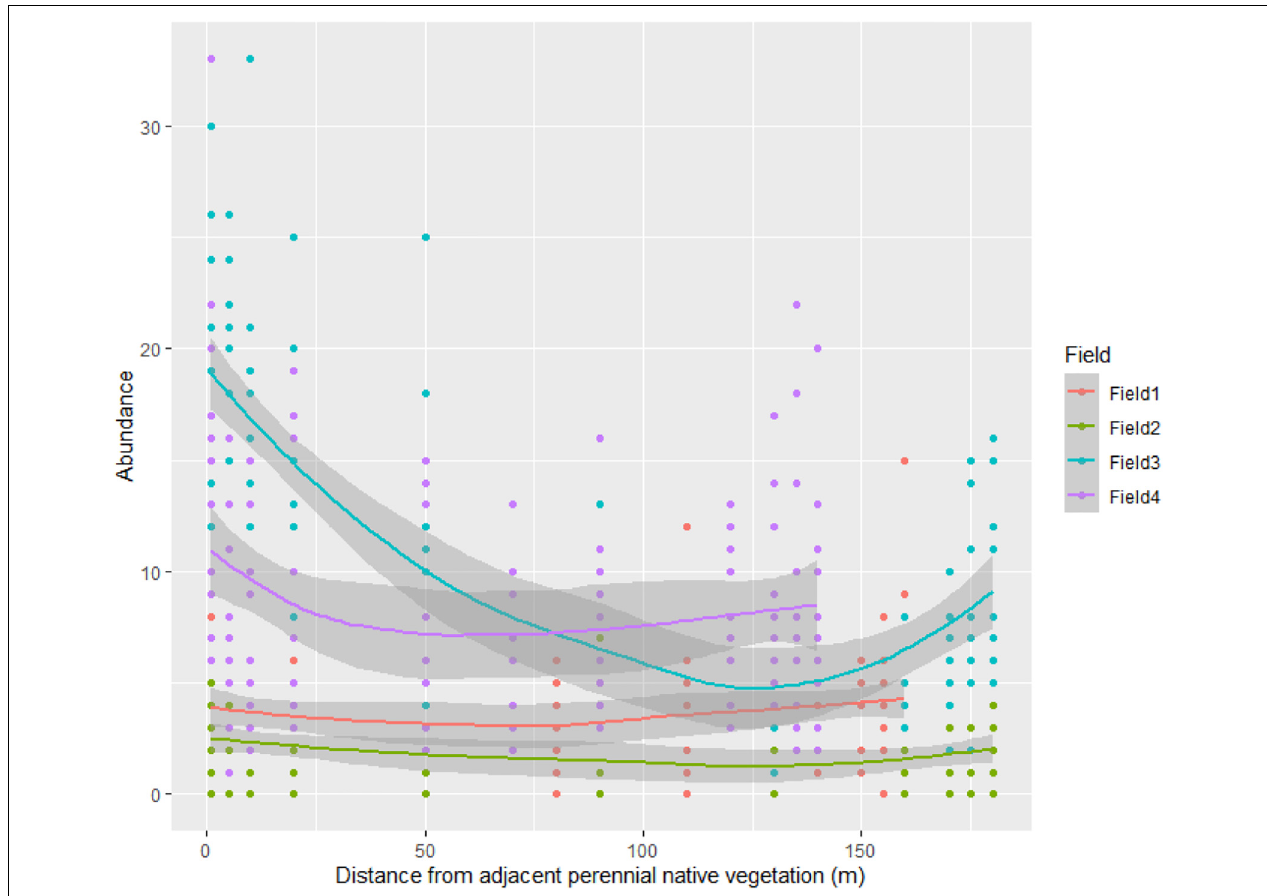
FIGURE 4 | Spatial distribution of the ground active predators (pitfall trap catches) in fields with perennial woody vegetation adjacent to one margin (the zero position) but with contrasting levels of pesticide use quantified as a toxicity score (pale blue = low; purple = moderate; red = high; green = very